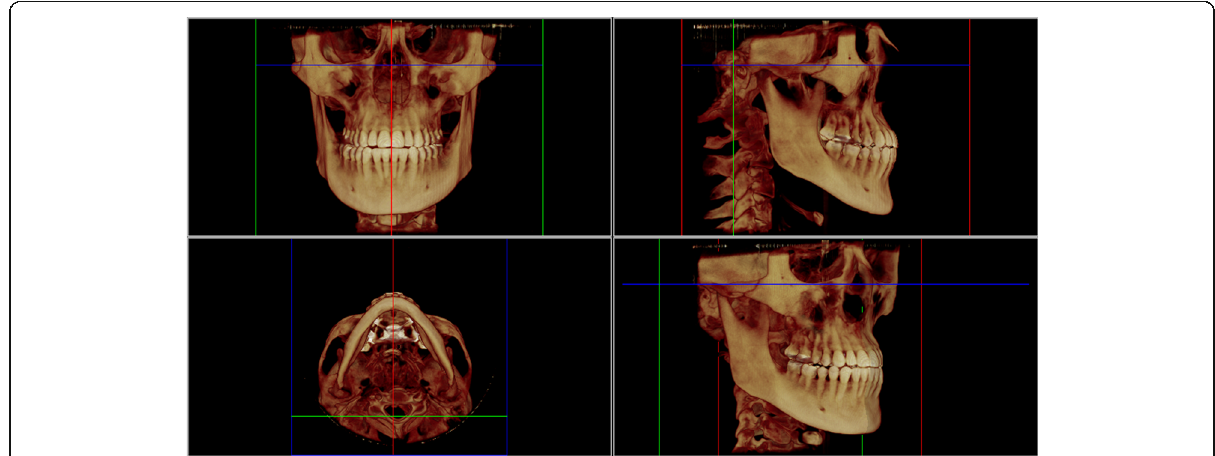
Fig. 1 Reference planes: axial plane coincident with Frankfurt horizontal plane ( blue ), coronal plane coincident with transporionic plane ( green ), and sagittal plane coincident with midsagittal plane ( red